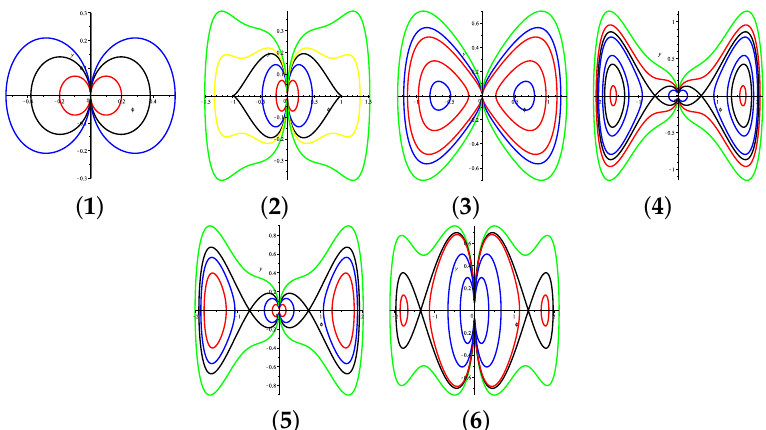
Figure 5. Phase portraits corresponding to system (5) under c > 0, ( 2 β − α )( a − 2 α ) < 0, a − 2 α > 0.